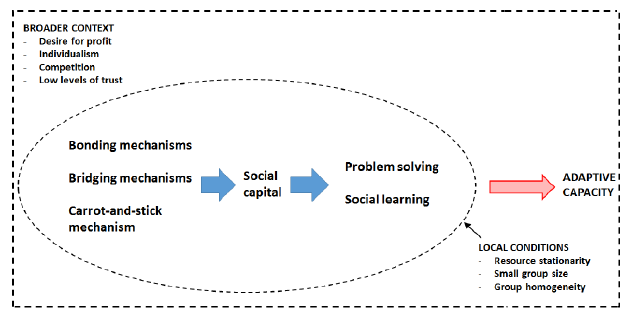
Fig. 7 . The evolution of mechanisms throughout the life span of the Lincoln Water Transfer Limited